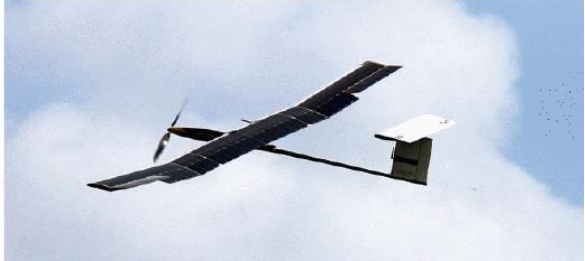
Figure 15. Atlantiksolar solar-powered drone in Switzerland. Reproduced with permission from Ref. [70]; published by IEEE, 2017.